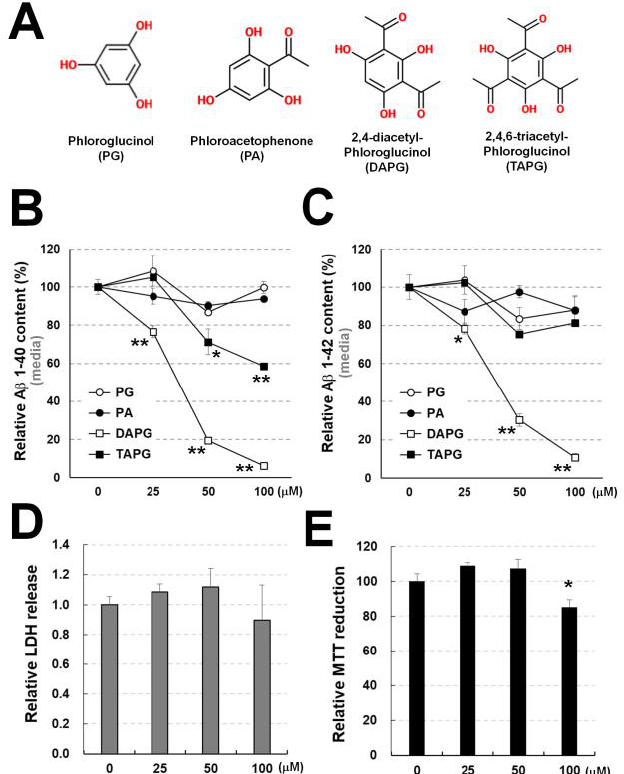
Figure 2. Examination of the potential of phloroglucinol and acetylphloroglucinols to lower Aβ levels. ( A ) Chemical structures of phloroglucinol and acetylphloroglucinols. ( B , C ) ELISA analysis of Aβ 1–40 ( B ) and Aβ 1–42 ( C ) levels in the culture medium of 293sw cells treated with the indicated doses of the compounds for 8 h. ( D , E ) LDH release ( D ) and MTT reduction ( E ) assays after treatment with the indicated doses of DAPG for 8 h. Values in panels B–E are presented as means ± SEMs (n = 3). Statistical significances of the differences between treated cells and untreated controls